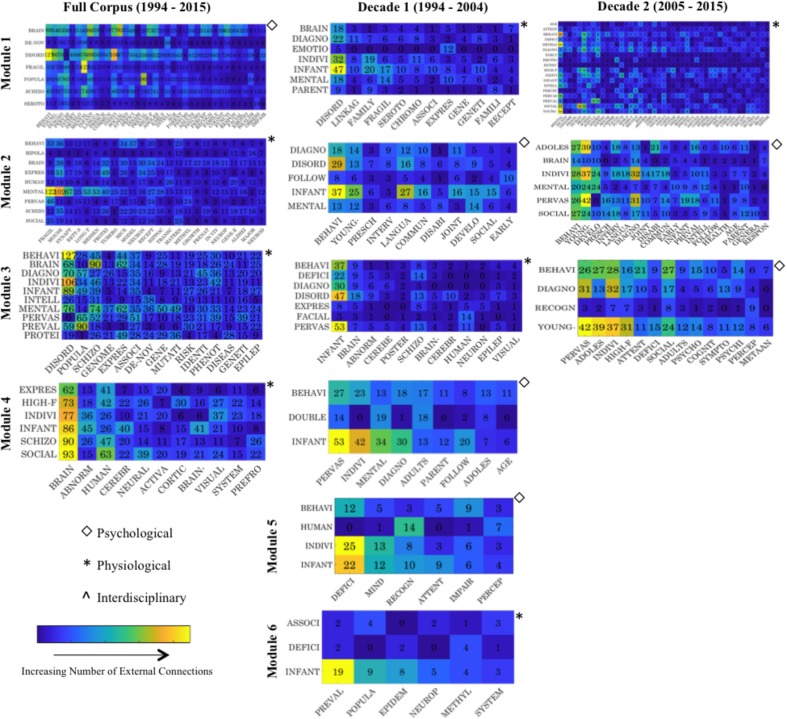
Summary matrices visualizing the external connections between modules within the refined network, i.e., network trimmed of corpus descriptor hubs such as ‘Autism.’ Prominent internal module nodes (keywords) are indicated on the x-axis, while core external partner nodes are represented on the y-axis. Colors are indicative of normalized levels of external connectivity, with lighter colors denoting a larger number of normalized connections (note: original count data is indicated. The left panel provides module networks for the Full corpus, while the two right panels provide those for Decade 1 and Decade 2 respectively). For larger high resolution figures please see https://figshare.com/s/aa56fdd878db4a04a521.